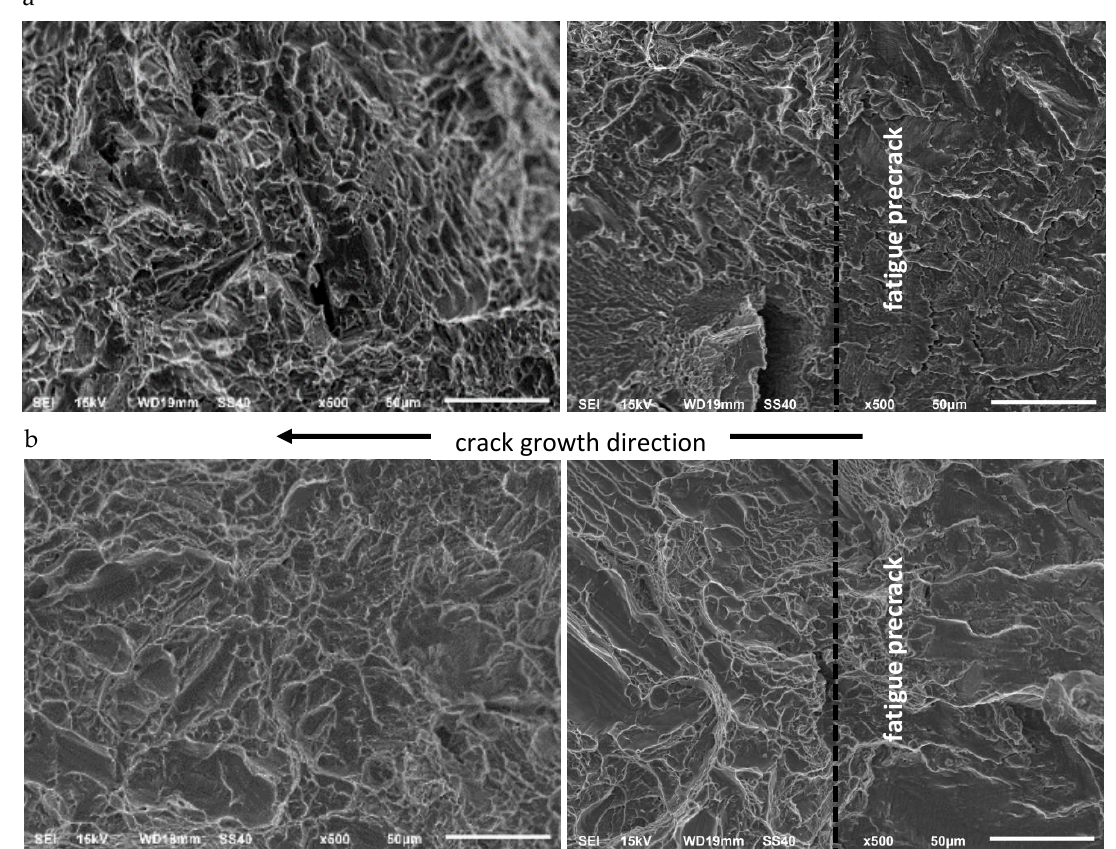
Figure 11. A comparison of fracture surfaces of CT specimens made of Ti6Al4V titanium alloy at 293 K ( a ) and at 77 K ( b ).